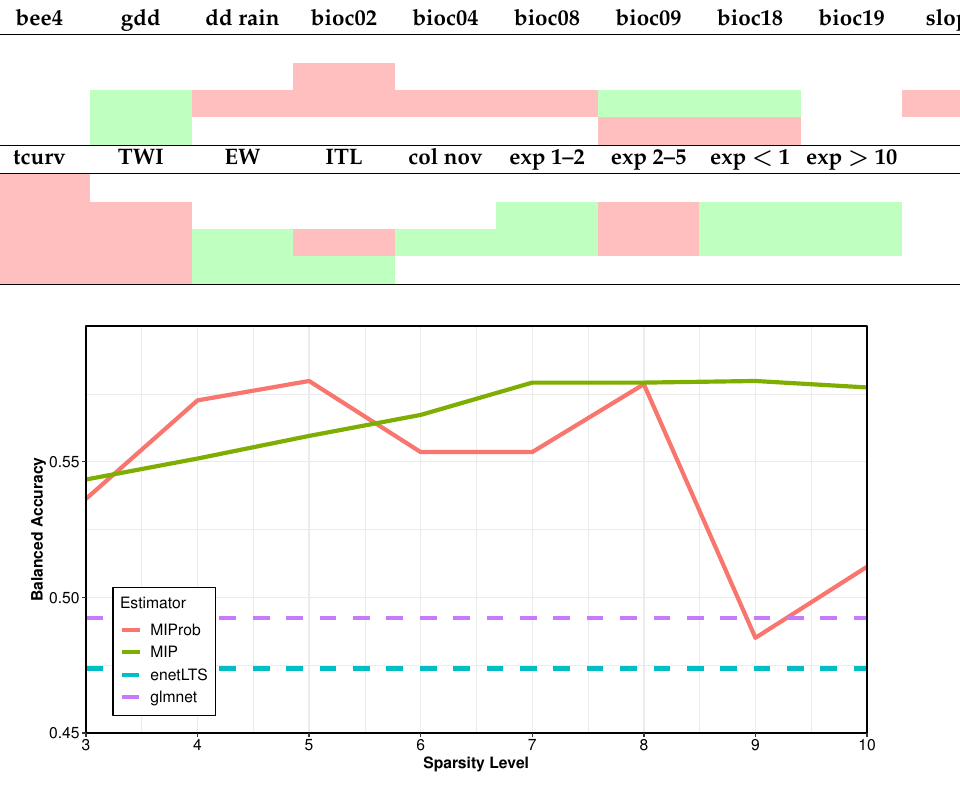
Table 3. Features selected by Lasso, MIP, enetLTS and MIProb (robust MIP) on a training set encompassing 100 points. Green and red cells indicate estimated coefficients with positive and negative signs, respectively. White cells indicate non-selected features.